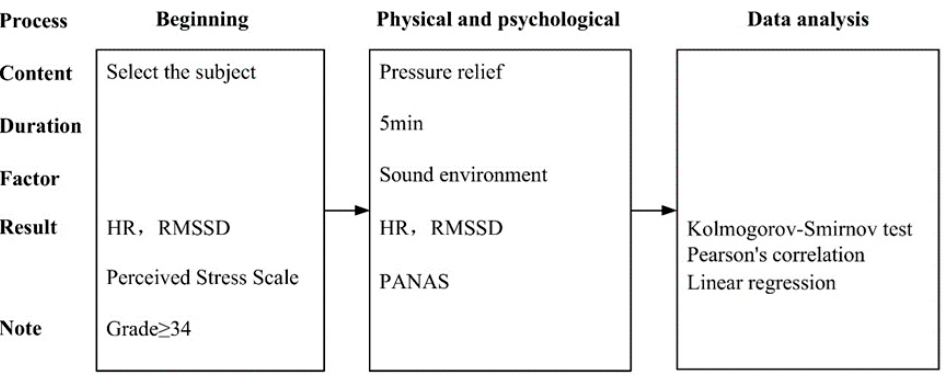
Figure 7. Experimental research process.